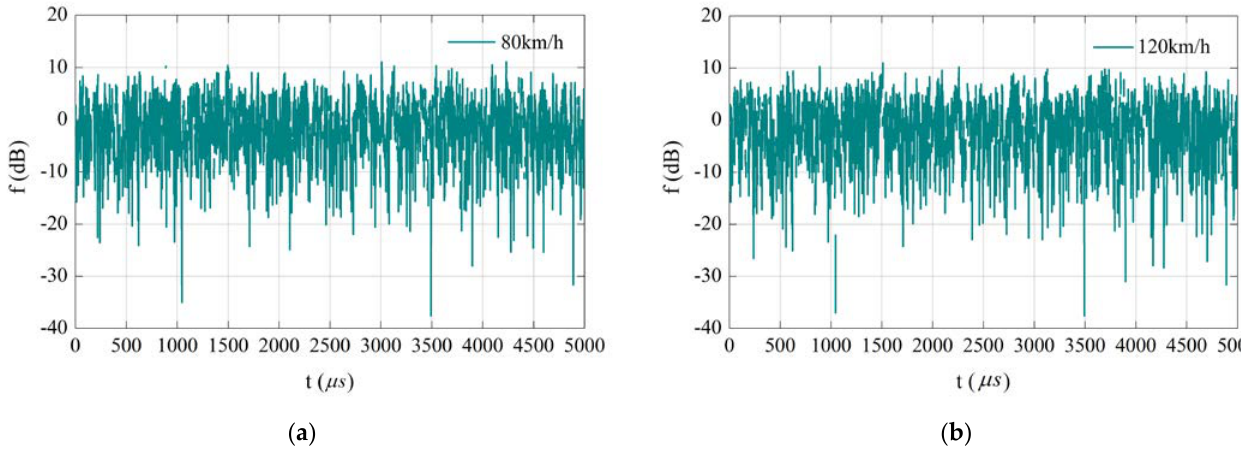
Figure 9. Influence of Doppler on signal fading at different velocity. ( a ) Influence of Doppler effect on channel fading at 80 km/h flight speed; ( b ) Influence of Doppler effect on channel fading at 120 km/h flight speed.